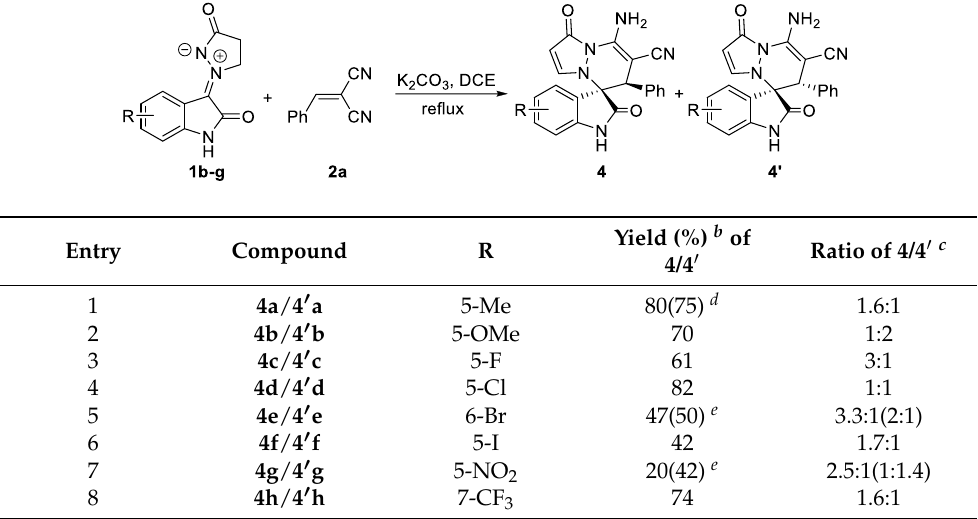
Table 3. Synthesis of dicyclic spiropyridazine oxindoles 4 and 4′ from isatin N , N ’ -cyclic azomethine imines 1b – g and Knoevenagel adducts 2a a .